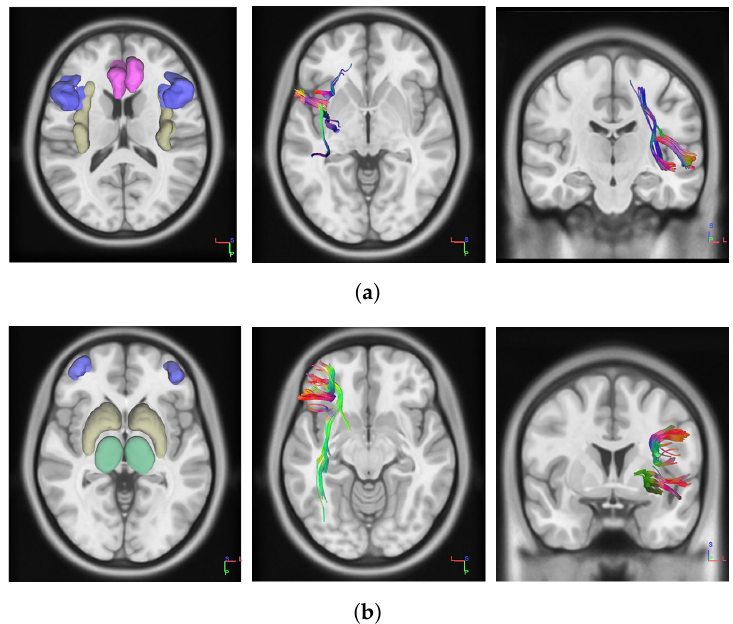
Figure 1. Pictures on the left show the regions of interest (ROIs) which constitute the networks. The network containing anterior cingulate (red), insula (yellow) and inferior frontal gyrus (blue) consists of the anterior cingulate cortex (ACC)–Insula–inferior frontal gyrus (IFG) Network ( a ). The network containing thalamus (green), striatum (yellow) and dorsolateral prefrontal cortex (dlPFC) (blue) consists of the dlPFC–Thalamus–Striatum Network ( b ). The central and rightmost pictures represent tracts of white matters connections for the first and the second network, respectively. For simplicity, figures show networks tracts for the left brain hemisphere, but the same applies to the opposite hemisphere. Network Fractional Anisotropy (FA) is intended to account for bilateral network tracts fractional